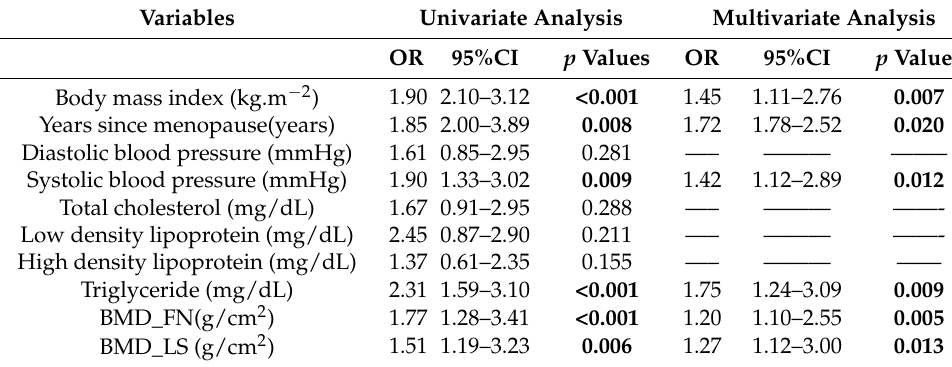
Table 2. Regression analyses for the identification of independent risk variables. Variables Univariate Analysis Multivariate Analysis OR 95%CI p